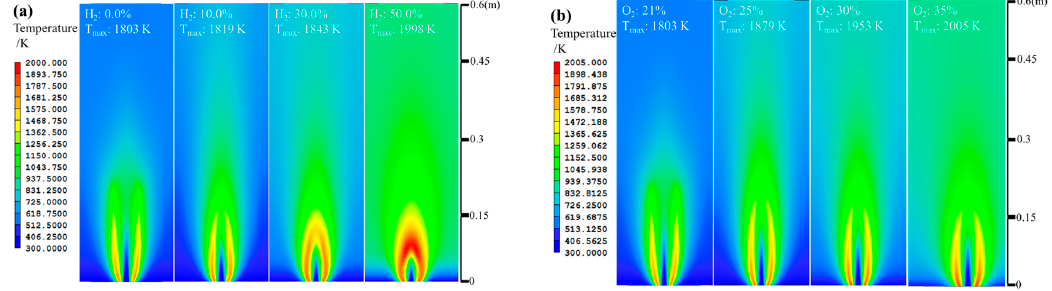
Figure 5. Effects of H 2 addition ratio ( a ) and O 2 enrichment levels ( b ) in BG-2/air flame on the distribution of combustion temperature.